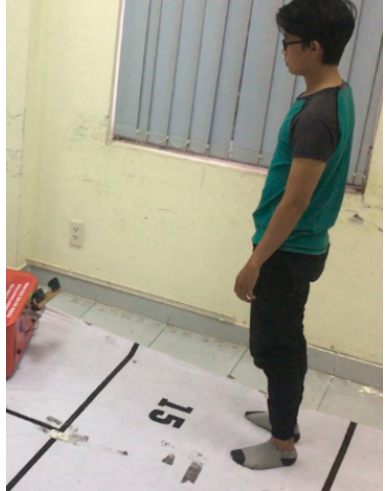
Figure 12. Experiment to estimate the distance statically by using digital cameras.